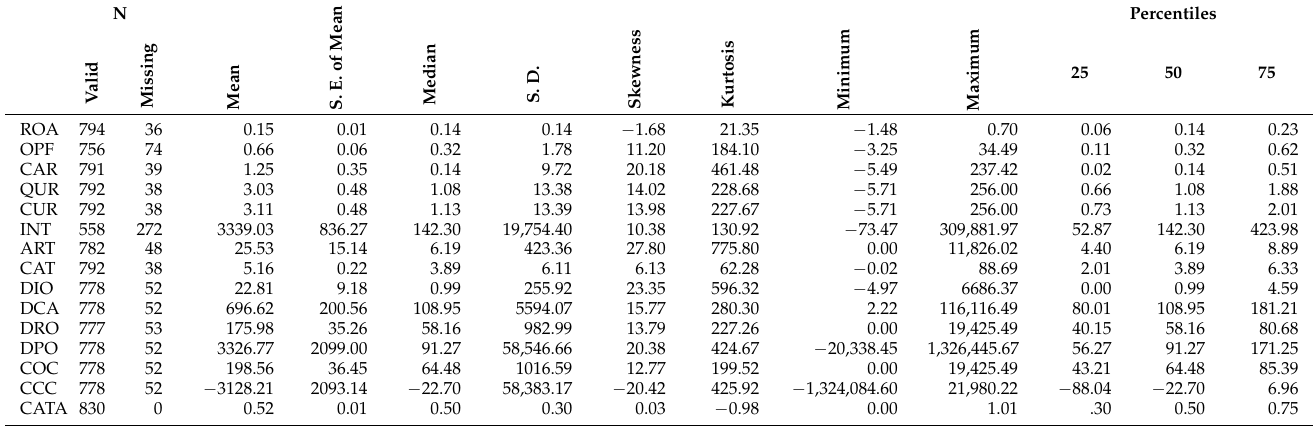
Table 4. Descriptive statistics for transport companies in the Slovak